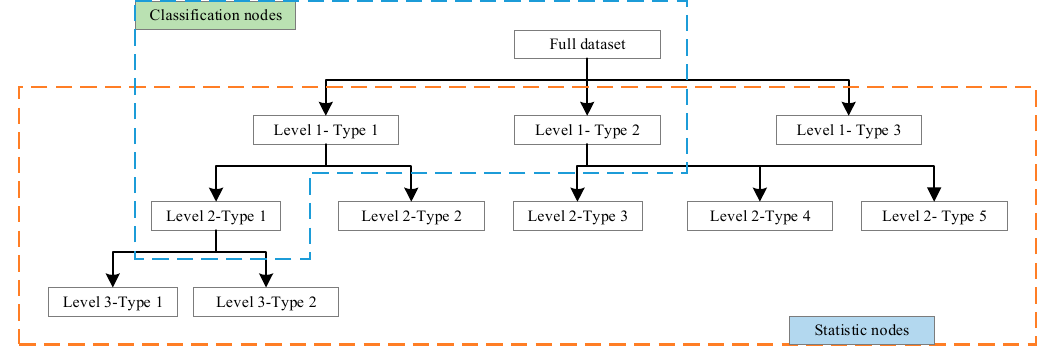
Figure 4. Hierarchical organization of land cover types.